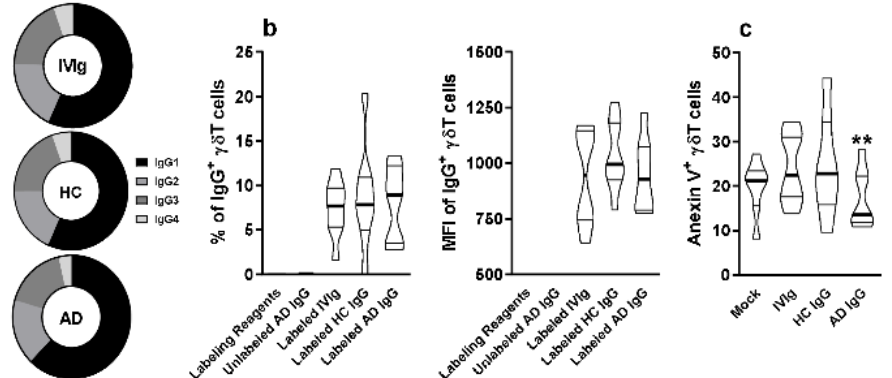
Figure 3. Evaluation of IgG subclass frequency and their direct interaction with thymic γδ T cells. ( a ) Frequency of IgG1, IgG2, IgG3, and IgG4 isotypes in IVIg and purified AD IgG was evaluated. Thymocytes from children under 7 days old ( n = 12) were incubated for 30 min with labeling kit reagents (Without IgG), unlabeled AD IgG, labeled IVIg, labeled HC IgG, or labeled AD IgG. ( b ) Frequency and ( c ) intensity of IgG staining (IgG+) or ( c ) frequency of Anexin V staining (Anexin V+) on thymic γδ T (CD3+ γδ TCR+) cells. Pie charts represent the frequency of each IgG isotype within the total amount of detected IgG. Violin plots represents values distribution from minimum to maximum, thick lines represent quartiles, and bold lines represent the mean. ** p ≤ 0.05 when compared to the Mock, IVIg, and HC IgG conditions.